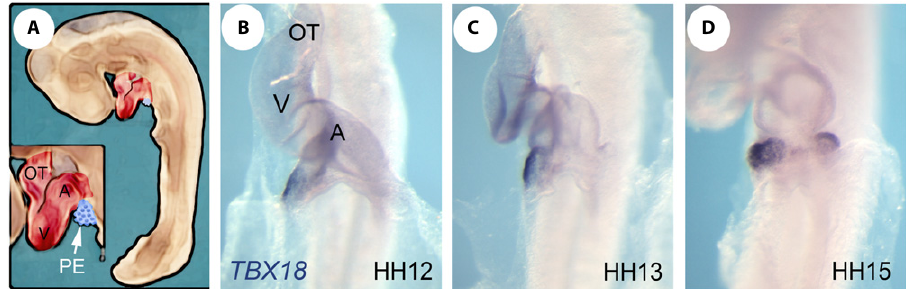
Figure. 1 Proepicardial marker gene expression. (A) The PE develops at the venous pole of the early heart tube (red)asaclusterofvillousprotrusions(blue).(B–D)Inthechickenembryo,proepicardialmarkergeneexpression represented by TBX18 can first be detected at stage HH 11–12 (B), which is approximately three stages before the onset of villous outgrowth on the right sinus horn. (C) Expression persists during the entire period of PE formation.NotetheasymmetricexpressionbeingunilaterallypresentontherightsinushornbetweenHHstages 11–14. (D) By HH stage 15 also on the left side a much smaller expression domain is observed. A (atrium), OT (outflow tract) V (ventricle). Panel B–D are taken from: Schlueter, J and Brand, T. (2009). A right-sided pathway involving FGF8/Snai1 controls asymmetric development of the proepicardium in the chick embryo. Proc Natl Acad Sci USA